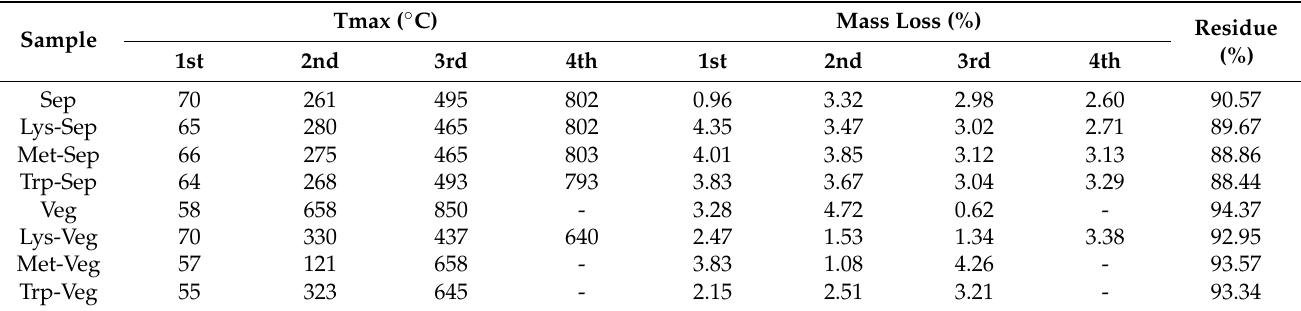
Table 3. Values of maximum temperatures and respective mass losses in each event obtained from the TG/DTG